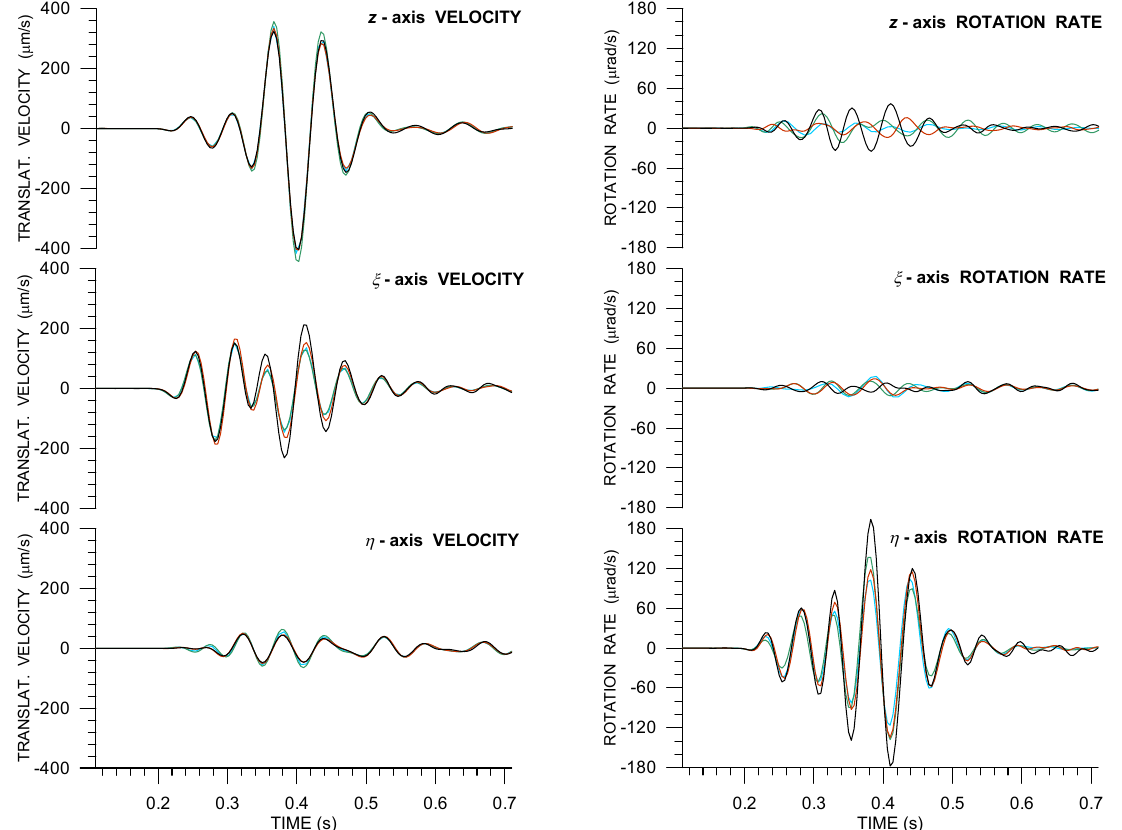
Figure 4. A small-size explosion (Expl2 in Table A1) at a distance of 52 m from the vault as recorded by four 6C Rotaphone- CY instruments (R8—red, R10—black, R11—light blue, and R13—green) in the huddle test. Horizontal components are rotated into radial and transverse directions according to the geometrical azimuth of 305.6 ◦